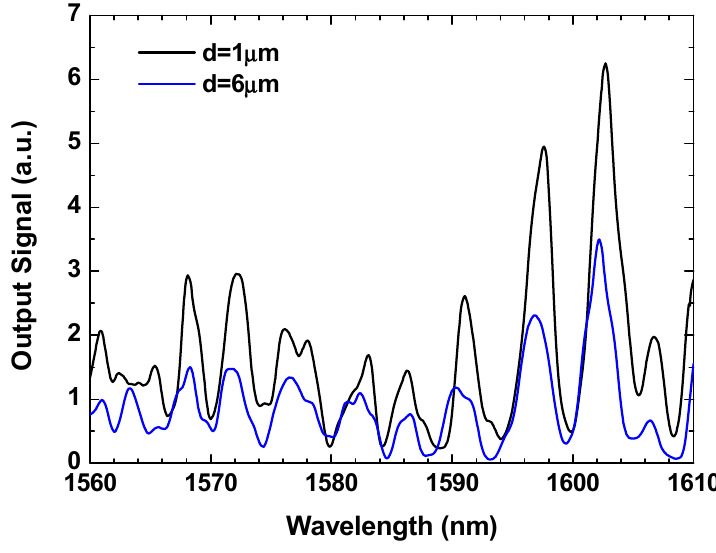
Figure 2. Sensing head interferometric signal output, for a cavity length of 2.5 cm and two different distances.